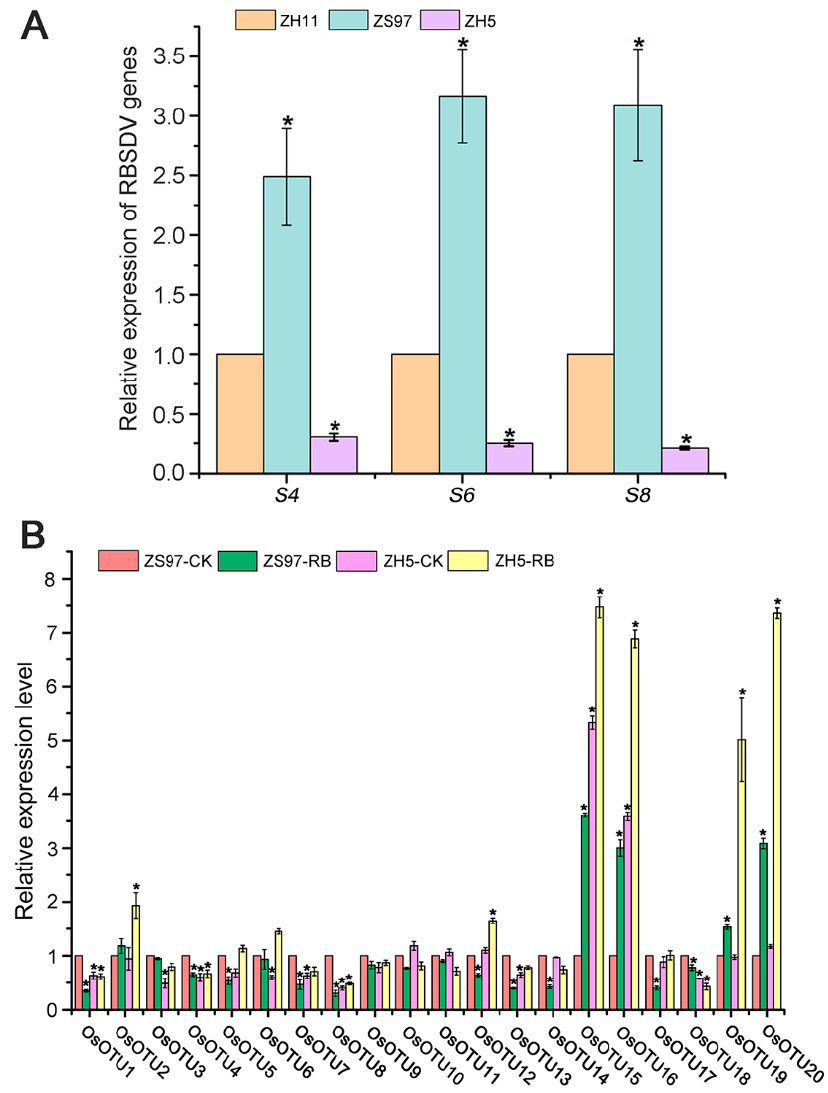
Figure 10. Differential expression analysis of resistant ZH5 and susceptible ZS97 plants after RBSDV infection. ( A ) RT-qPCR results showing the relative expression of viral RNA (RBSDV genomic RNA segments S2, S4, and S6) in RBSDV-infected ZH11, ZS97, and ZH5 plants. ( B ) RT-qPCR verification of the expression of OsOTU genes between resistant ZH5 and susceptible ZS97 after RBSDV infection. Three biological replicate experiments were performed. Samples were collected at 30 dpi from RBSDV-infected ZH5 and ZS97 plants. The OsUBQ5 gene was used to normalize the relative gene expression level. Error bars represent ± SE ( n = 3). * indicates significant differences from the mock control at p ≤ 0.05 by the Fisher’s least significant difference tests.